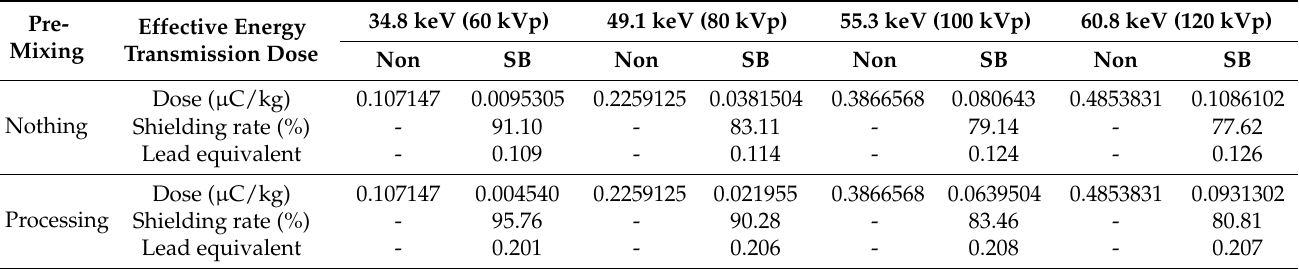
Table 2. Comparison of shielding barrier shielding performance with or without the pre-mixing process.